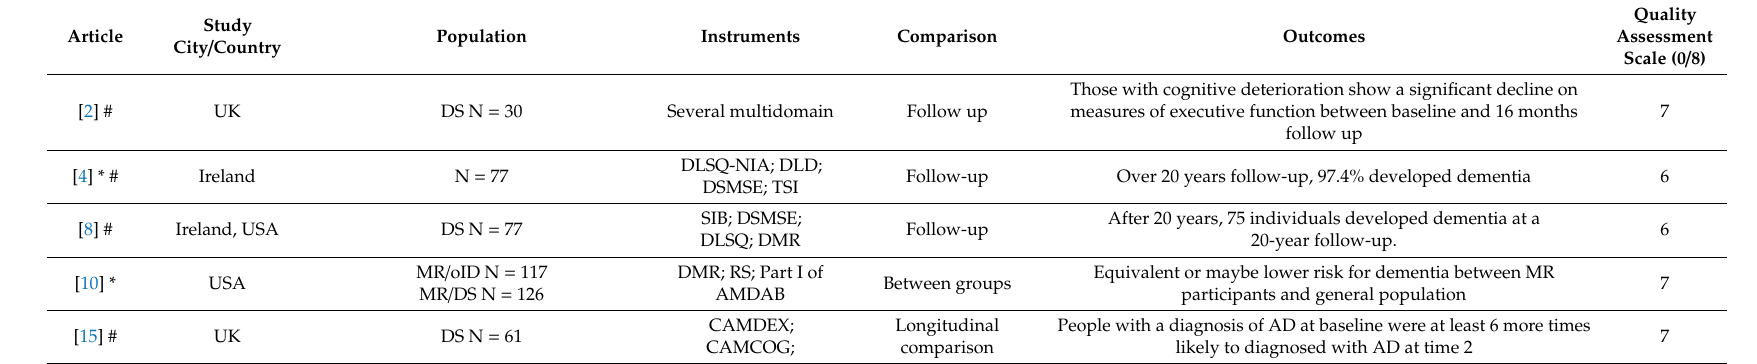
Table A2. Longitudinal Studies assessing cognitive changes in mixed groups of ID